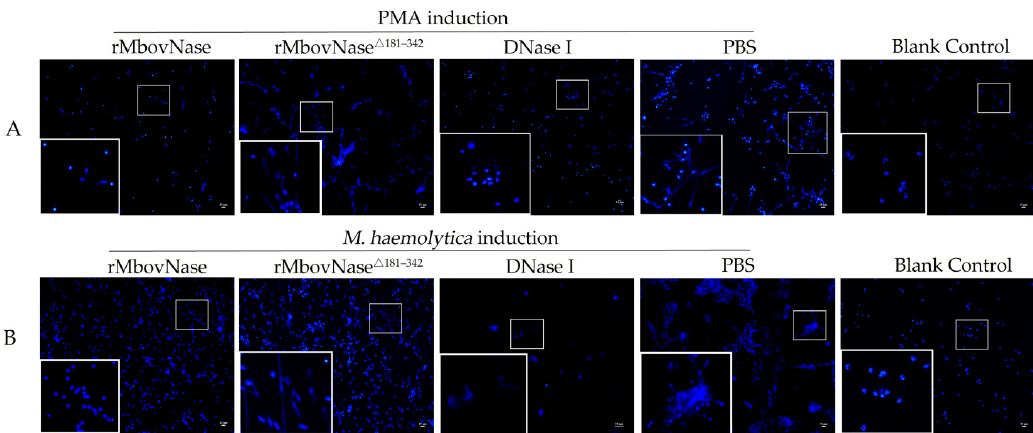
Figure 4. NETs degradation by rMbovNase and its variant rMbovNase Δ 181–342 . ( A ) NETs were generated by PMA induction; ( B ) NETs were induced by M. haemolytica . The rMbovNase and the variant, together with DNase I (positive control) and PBS (negative control) were added into activated neutrophils in both A and B, and only rMbovNase and DNase I apparently degraded NETs, while the variant and PBS did not. No treatment was performed in blank control. The fields in the small squares are zoomed in the large squares (magnifications: ×100; the zoomed images in the lower left boxes are ×3 magnifications of the images in middle small boxes).